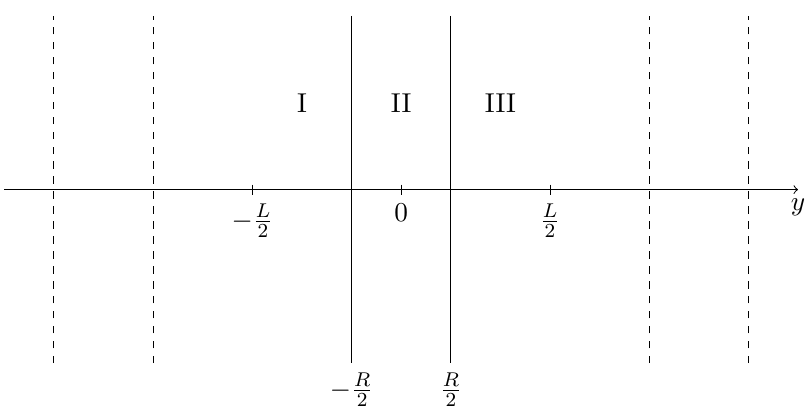
Figure 1 . The setup: periodic space (with period L ) along the extra dimension y , with two DGP branes (solid lines). The branes (with suppressed transverse dimensions) are repeated (dashed lines) after the period. I, II and III are the regions we need to match in order to find the field